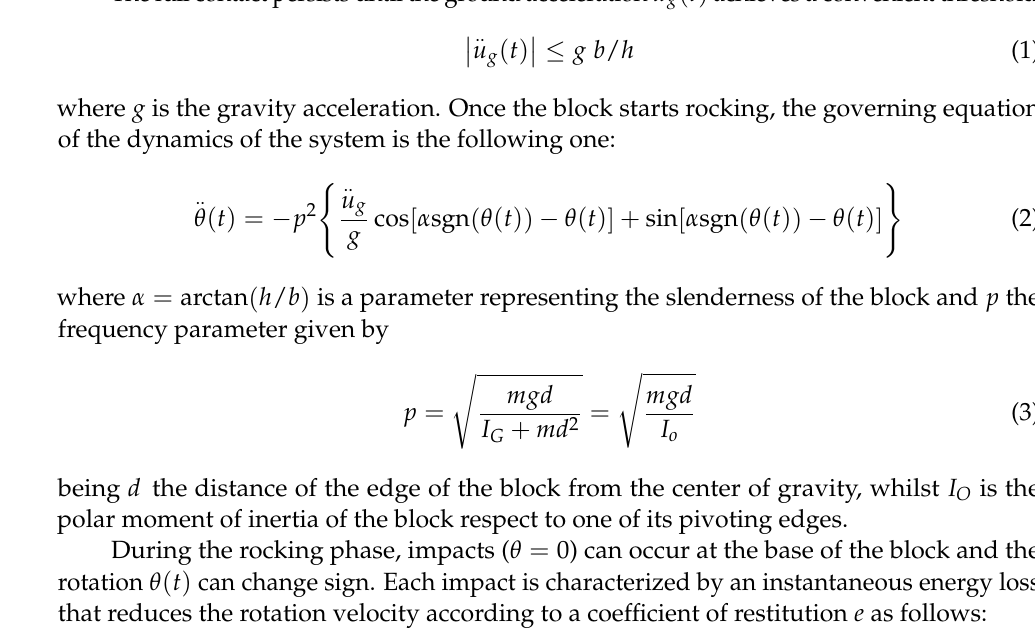
The full contact persists until the ground acceleration